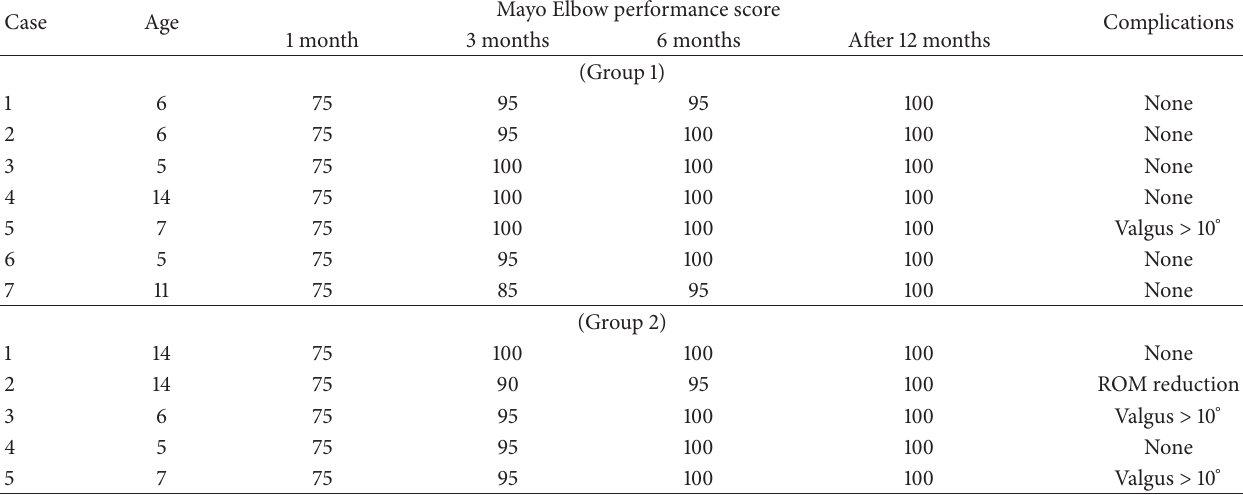
Table 2: Summary of results: MEP scores and complications.